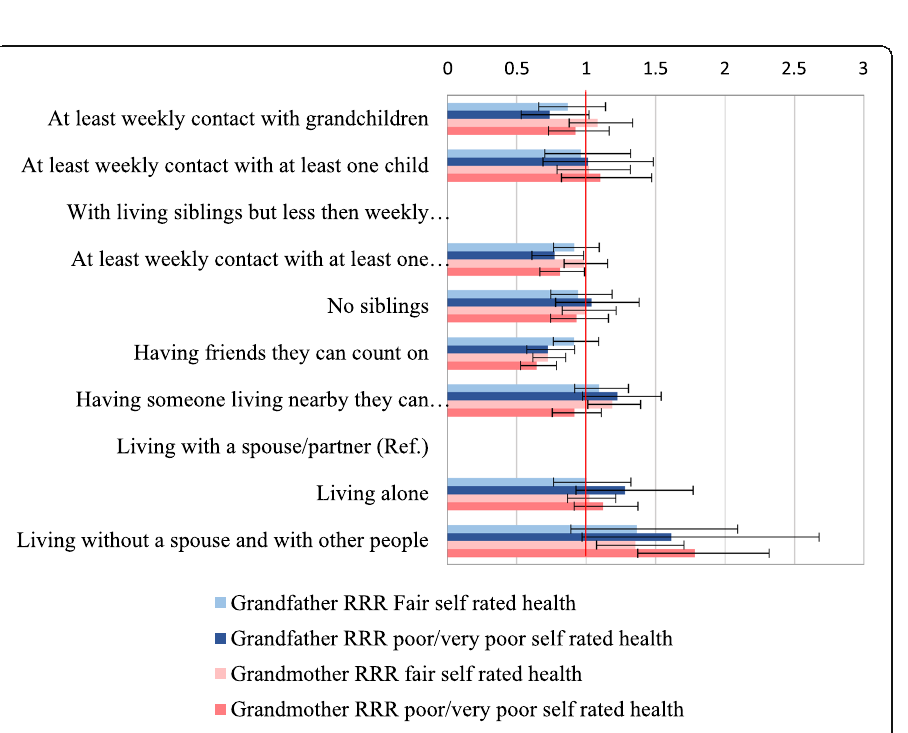
Fig. 3 Relative risk ratios (and 95% confidence interval) estimated by multinomial logistic regression model on the self-rated health status (ref. good health status). RRR are adjusted for age, educational level (high/ medium or low), living area (North, Centre or South of Italy), subjective financial situation, and working